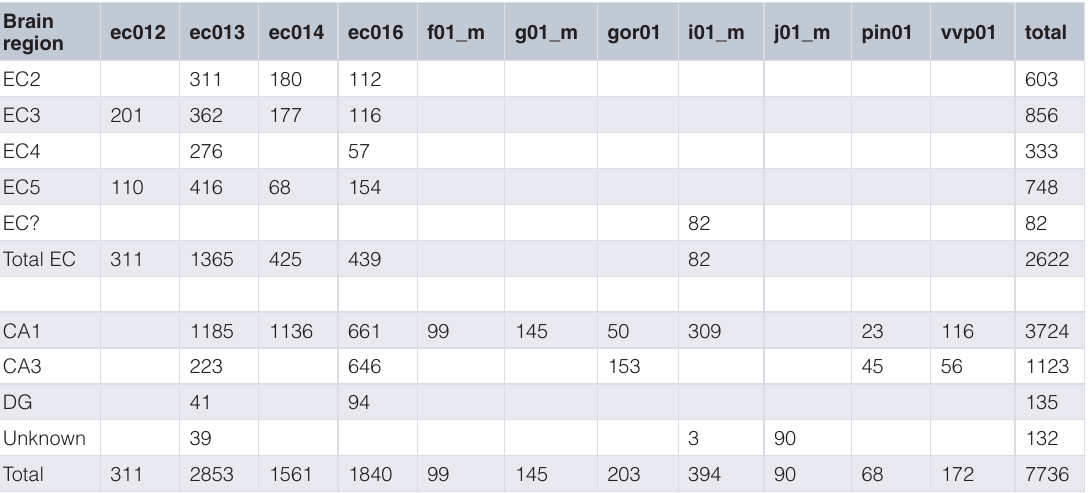
Table 2. Number of cells recorded. Top row: animal identifier. Left column: brain region. Brain region EC4 indicates either entorhinal cortex layer 3 or 5 (could not be determined which); region EC? indicates in entorhinal cortex, but without layer